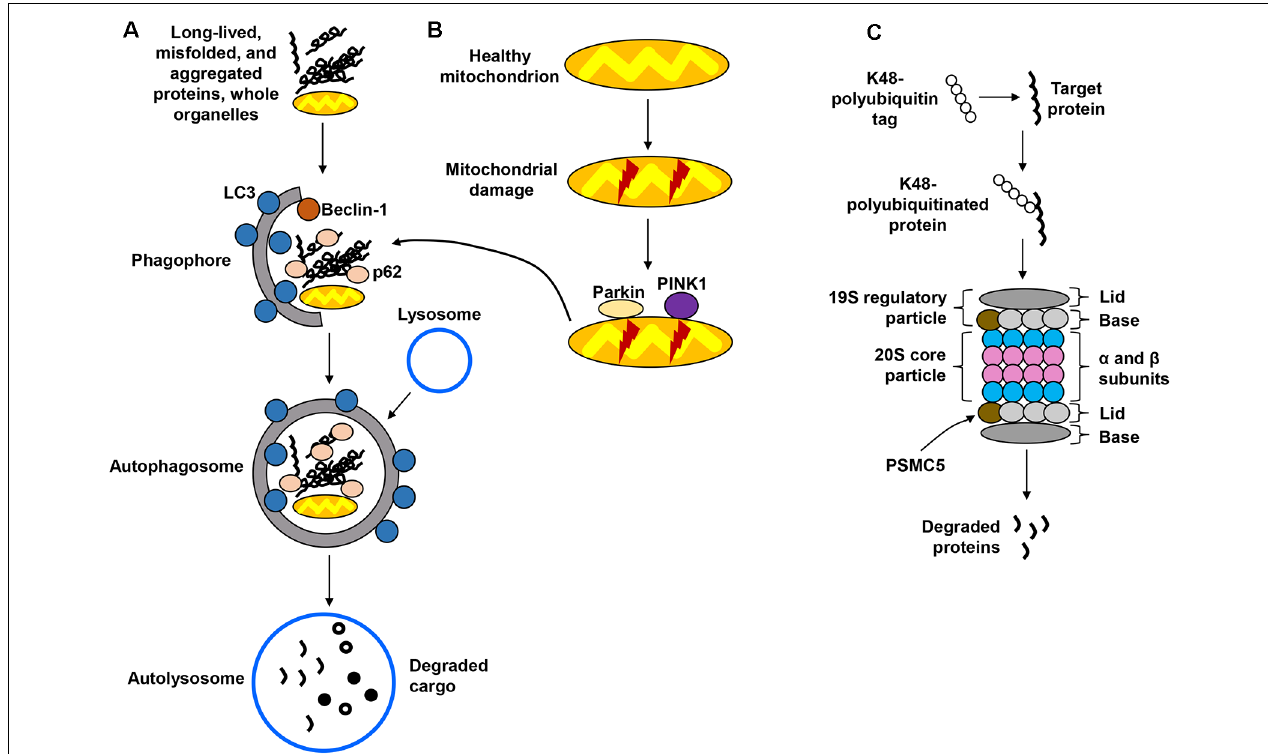
FIGURE 1 | Protein degradation pathways. (A) The autophagy-lysosomal pathway (ALP) is in charge of degrading long-lived and misfolded and aggregated proteins, as well as whole organelles. Components targeted for degradation are engulfed in autophagosomes, which are ultimately fused with the lysosome for cargo degradation. (B) Mitochondria are also degraded via the lysosome in a specialized form of autophagy called mitophagy, which recognizes damaged mitochondria through protein sensors (PINK1, parkin) that target the organelles for disposal via the ALP. (C) The ubiquitin-proteasome system (UPS) employs ubiquitin tags to target proteins for degradation through the 26S proteasome. Several steps in these pathways have been omitted for simplification.